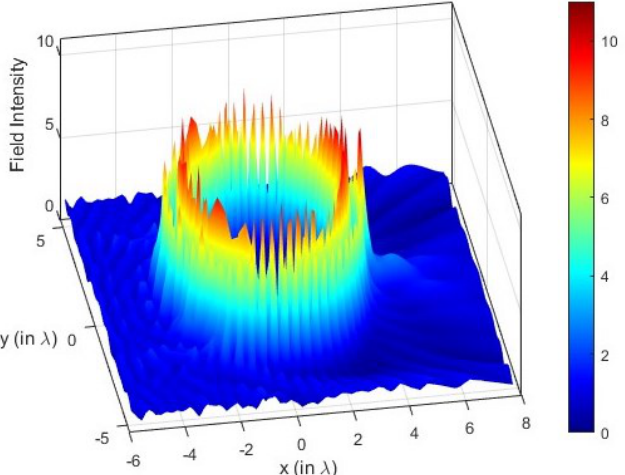
Figure 2. (Color online). Scattering on spheres with diameter: R = 3.5 and m = 2.89. Corresponding FWHM of the generated acoustojet is calculated as 0.29 λ .